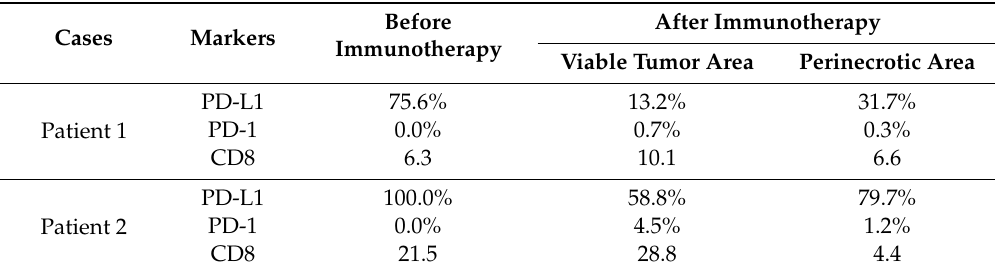
Table 1. Immunohistochemical expression of PD-L1 and selected biomarkers in non-small-cell lung carcinoma specimensbefore and after